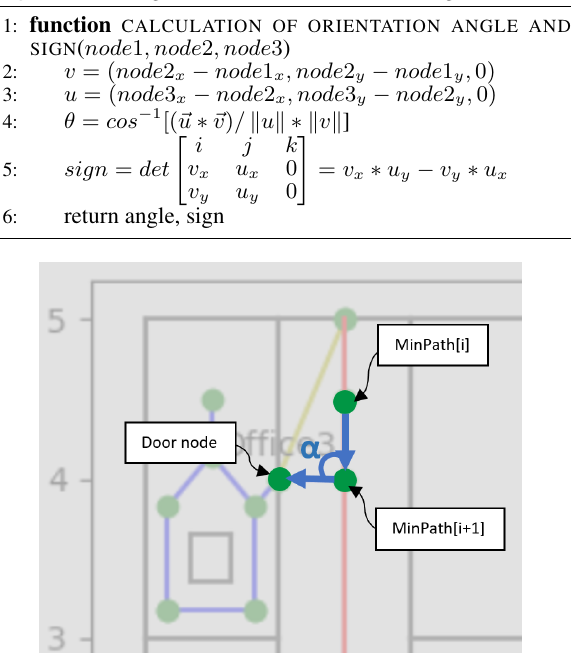
Figure 4. Cross product of two vectors in three consecutive nodes of the network to determine turning